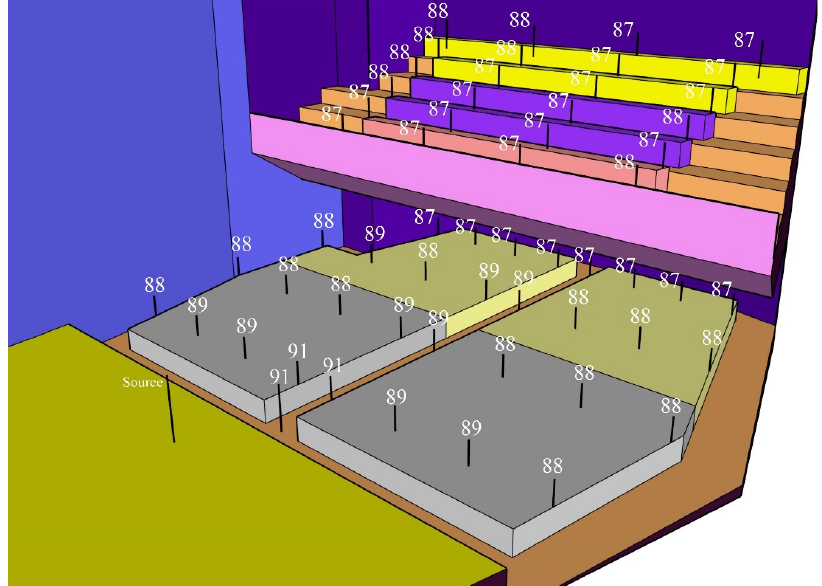
Figure 16. Map of the equivalent sound pressure levels, in dB, for the variable acoustic configuration (configuration R) which provides minimum sound absorption (adequate for music use).